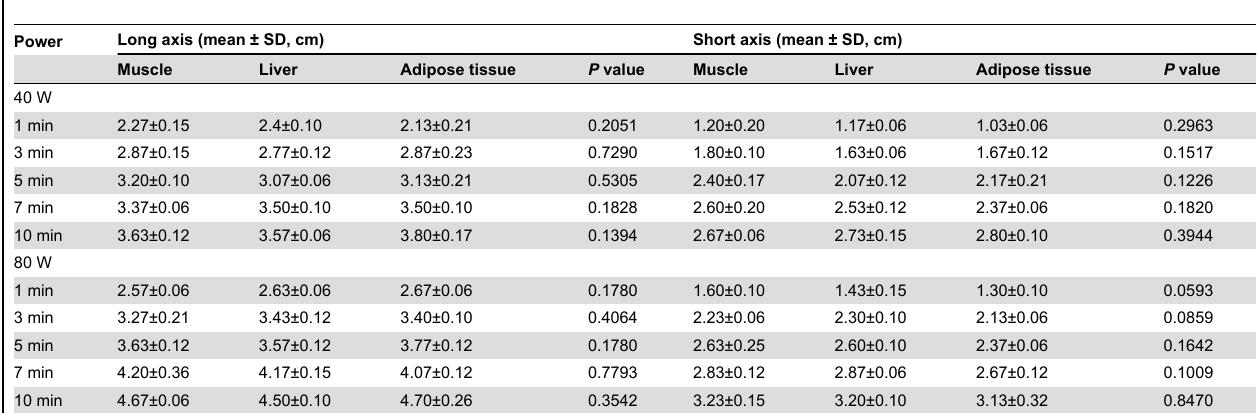
Table 1. Diameters of coagulation zones for microwave antennae at 40 W and 80